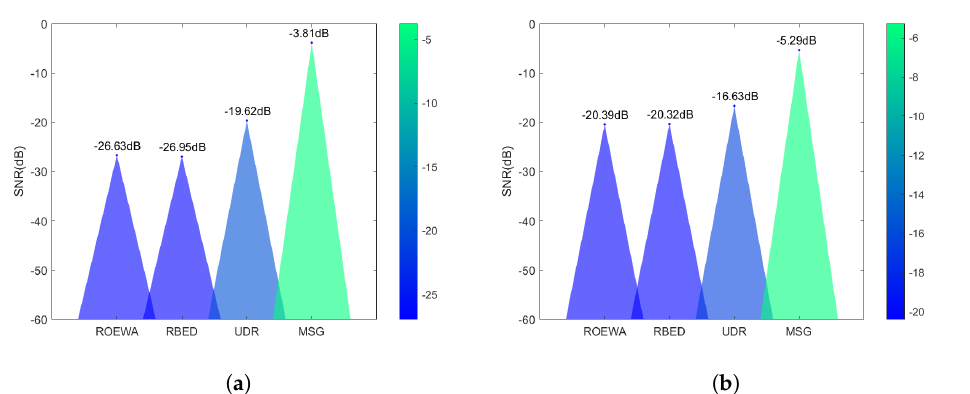
Figure 13. SNR of ROEWA, RBED, UDR and MSG on ( a ) the first one-look simulated SAR image and ( b ) the second one-look simulated SAR image.